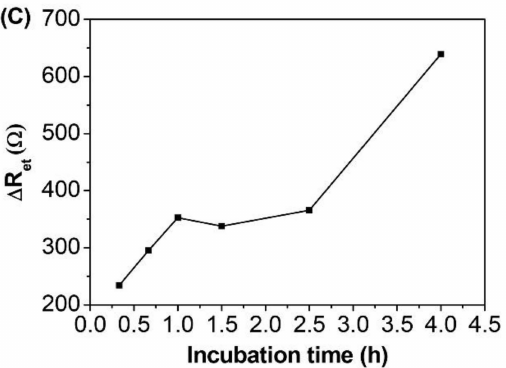
Figure3. E ff ectsofthereactiontimeforG6PAMAMcarboxylation( A ),thebindingtimeforAnti-EpCAM immobilization ( B ), and the incubation time for cancer cells recognition ( C ) on the assay performances. The ∆ R et in panel A is calculated as: ∆ R et = R PAMAM-COOH − R PAMAM . The ∆ R et in panel B is calculated as: ∆ R et = R Anti-EpCAM – R PAMAM-COOH . The ∆ R et in panel C is calculated as ∆ R et = R Cells − R BSA . Cell concentration, 1.0 × 10 6 cells mL − 1 .